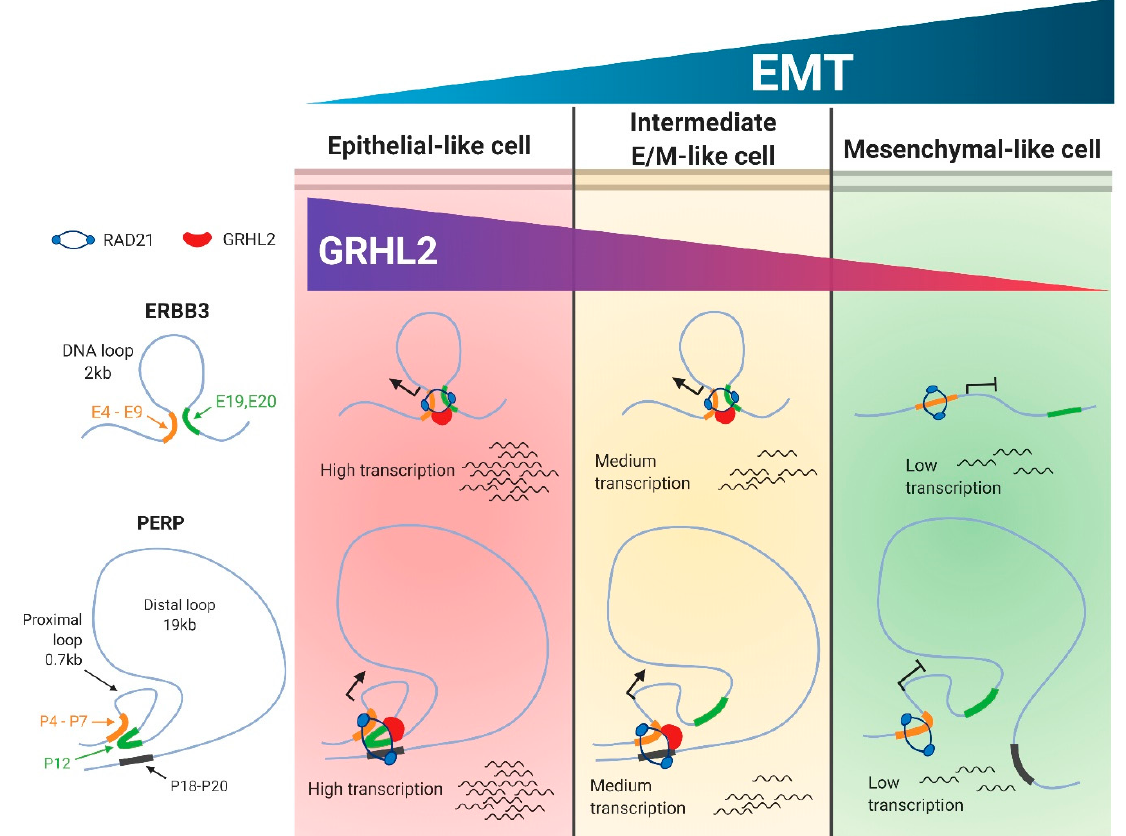
Figure 5. A hypothetical model illustrates that the gradual decrease in PERP and ERBB3 transcript levels along the EMT spectrum potentially correlates with the selective loss of RAD21 and GRHL2-mediated DNA looping structures. In an epithelial cell state, GRHL2 associates with RAD21 possibly to mediate intact chromatin loop structures bringing proximal and distal regulatory elements into the ERBB3 (top) and PERP (bottom) loci, and these structures might render abundant transcriptions. In the intermediate E/M-like cell state, the selective loss of RAD21/GRHL2 enrichment in the P12 amplicon region of the PERP loci potentially leads to the dissociation of proximal loop structures. There is no significant change in the ERBB3 loci. However, as these cells transit into a mesenchymal cell state, the loss of GRHL2 expression might lead to the distortion of cohesin structures connecting proximal and distal regulatory elements, which may result in the reduced transcriptional activity. Illustration created with Biorender.com.